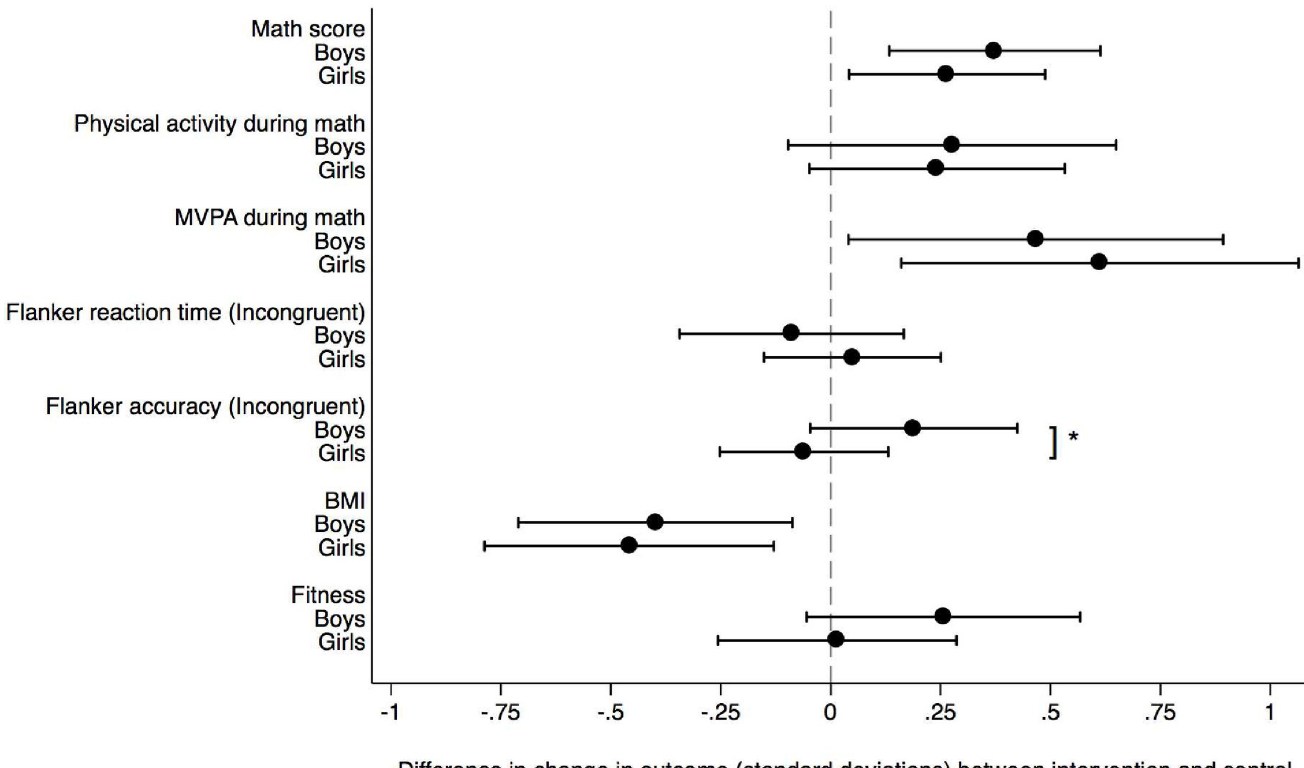
Fig 2. Sex-specific changes in outcomes. Sex-specific changes in outcomes in the intervention group relative to control (= 0) expressed in standard deviations from baseline to 9 months follow up. Mixed models estimates with school class as random effects, including baseline levels as covariates. Significant gender interaction: � p =